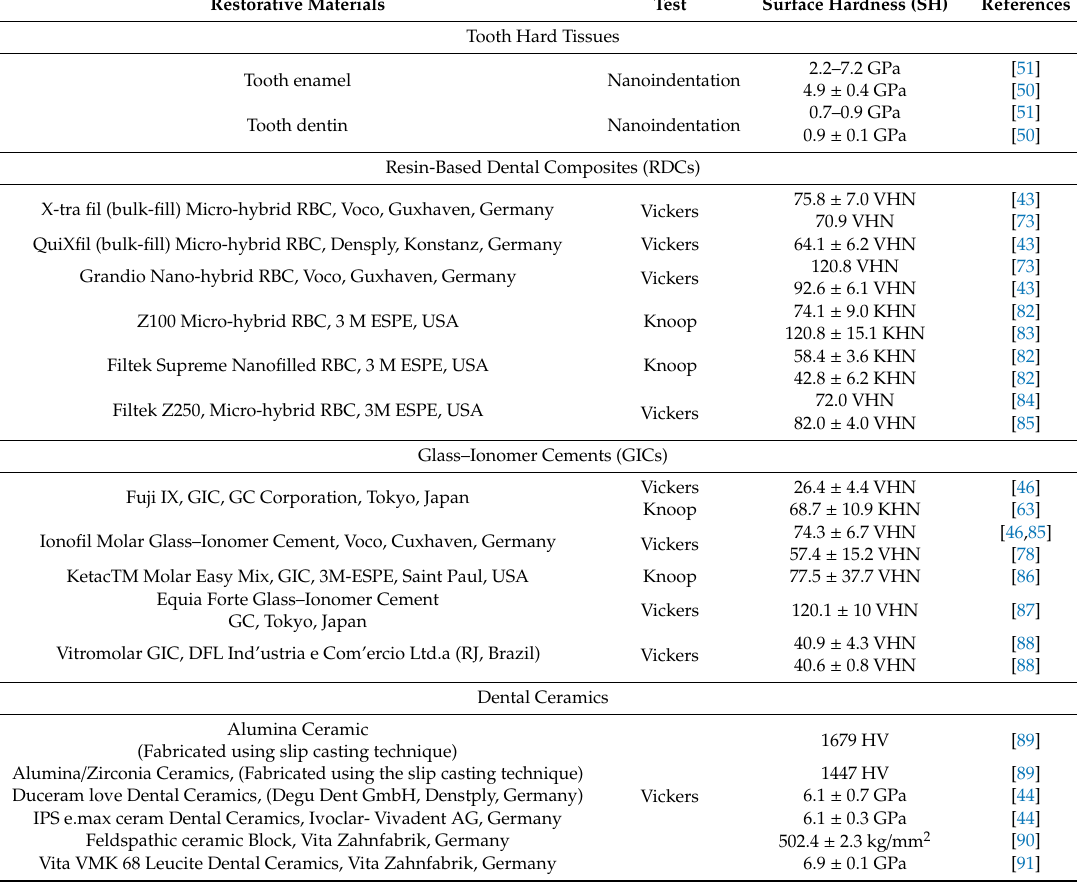
Table 2. Surface hardness of tooth-colored restorative materials and tooth hard